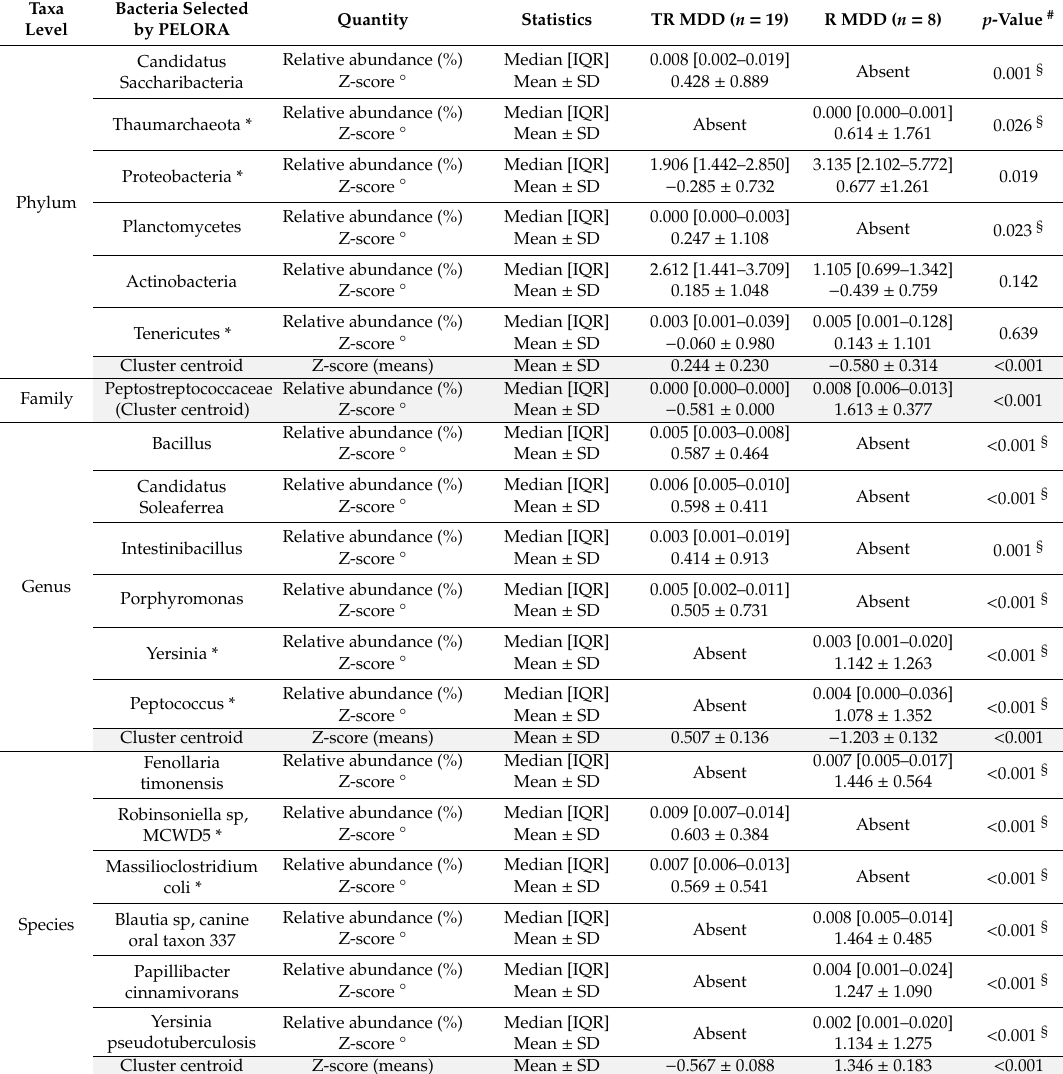
Table 4. Results from the penalized logistic regression analysis (PELORA) algorithm which identifies pathways of bacterial populations that best discriminate treatment-resistant (TR) and responder (R) MDD